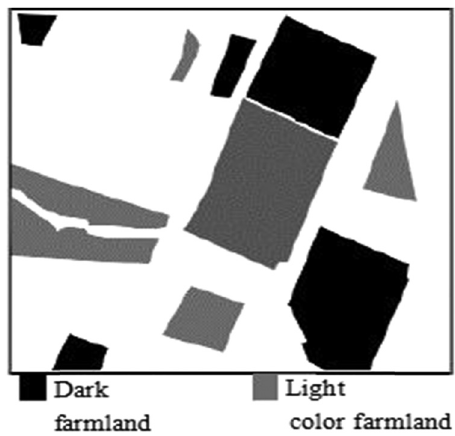
Figure 3: Farmland label